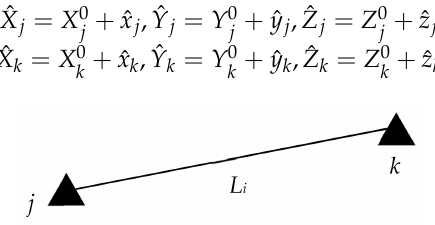
Figure 6. Diagram of side length